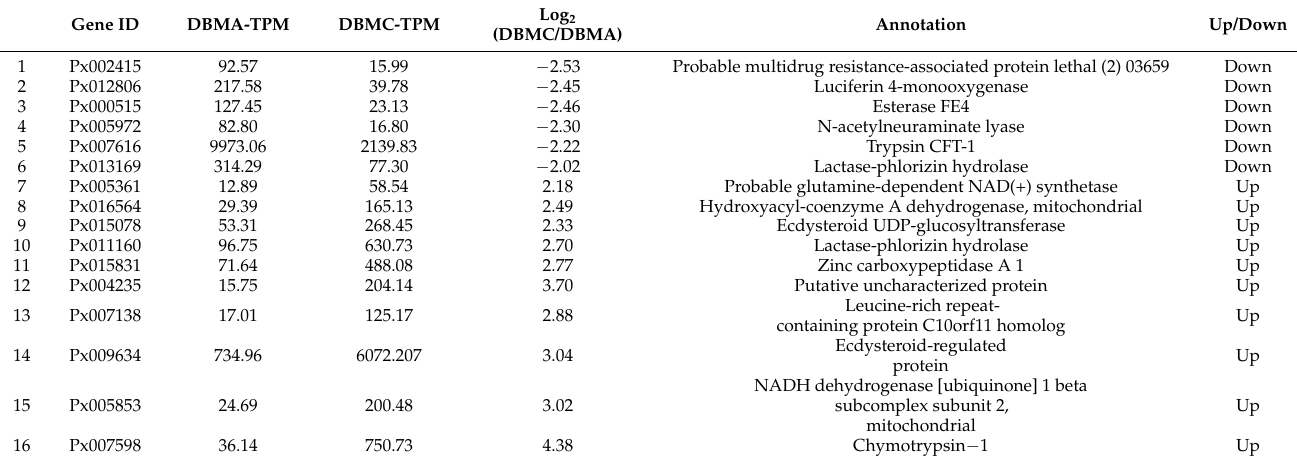
Table 4. Summary of the most significant 16 differentially expressed genes between susceptible and resistant strains. DBMA-TPM represents the TPM value of G88-susceptible strain, and DBMC-TPM represents the TPM value of Cry1S1000- resistant strain.